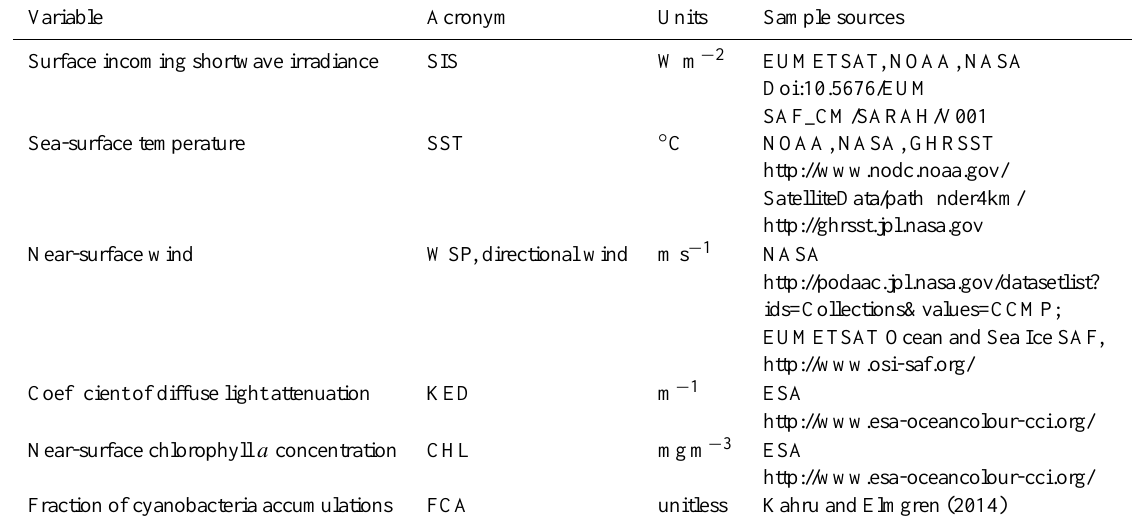
Table 1. Satellite-derived data sets used here to produce phenological indicators.